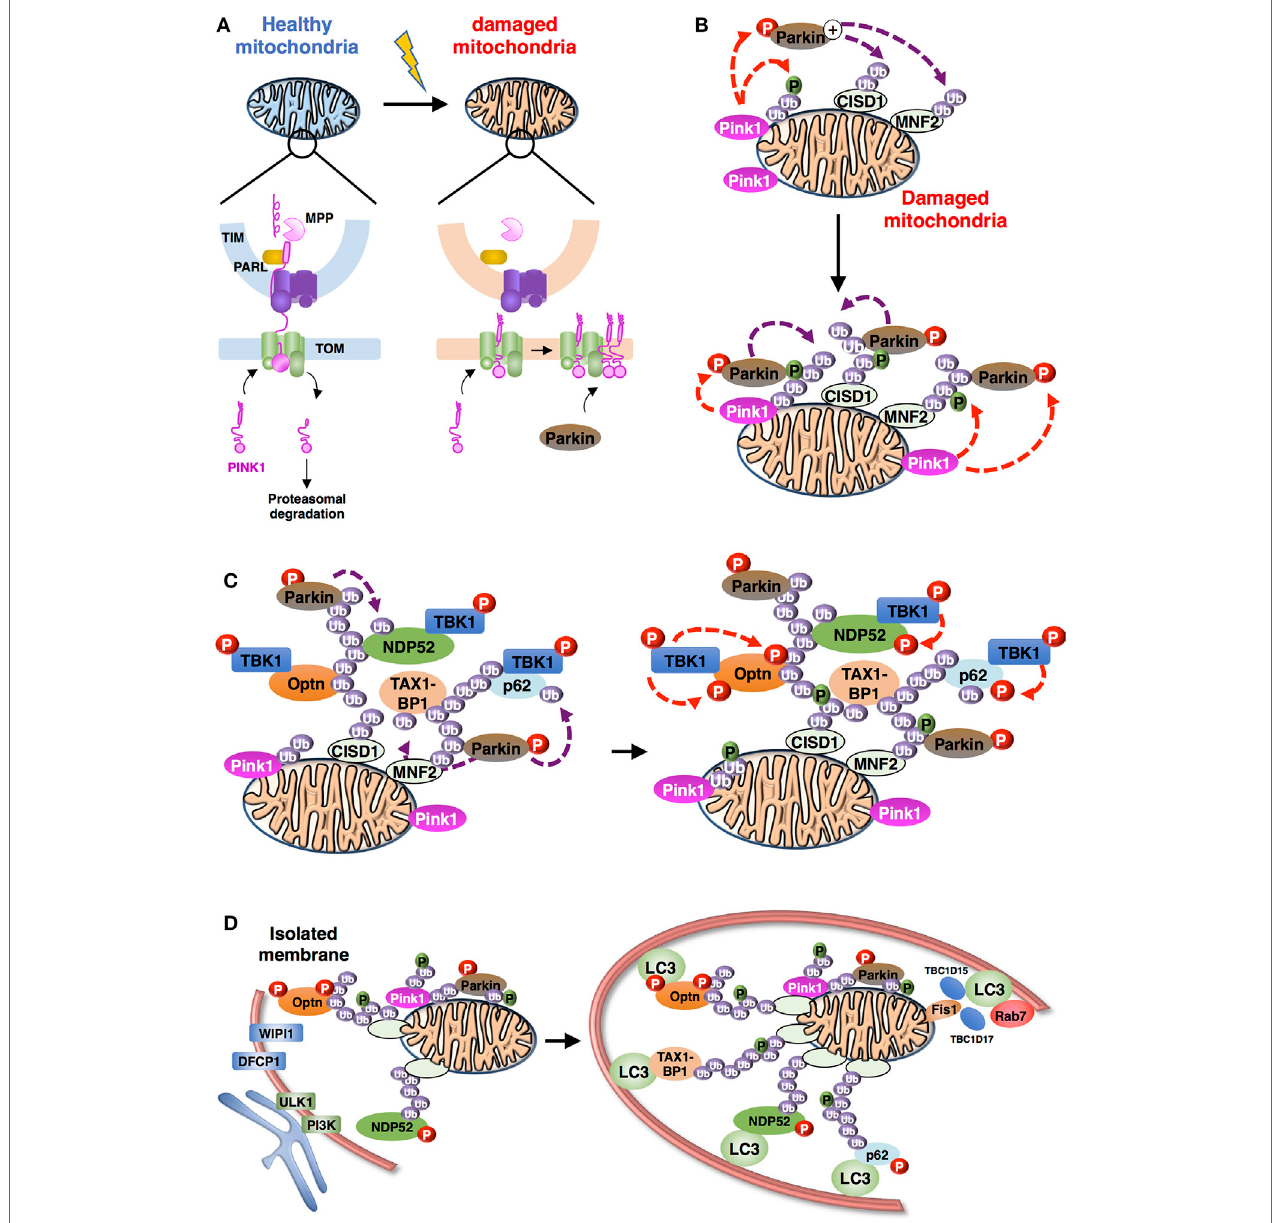
FigURe 3 | Schematic representation of the overall process of mitophagy [adapted from Ref. (36)]. (A) PINK1 import and accumulation mechanisms into mitochondria. PINK1 detects mitochondrial damage via selective proteolysis. Continuous import and the degradation cycle explain the undetectable levels of PINK1 on healthy mitochondria. Upon damage, import into the inner membrane is blocked leading to accumulation of uncleaved PINK1 on the outer mitochondrial membrane. Abbreviations: TOM, translocase of the outer mitochondrial membrane complex; TIM, translocase of the inner mitochondrial membrane complex; MPP, mitochondrial processing peptidase; PARL: presenilin-associated rhomboid-like protein. (B) Positive feedback ubiquitination cycles induced by Parkin and Ub chains on damaged mitochondria. Mitochondria-recruited PINK1 phosphorylate Ub chains conjugated to mitochondrial proteins, including CISD1 and MNF2 (shown here), as well as cytosolic Parkin, subsequently recruited to mitochondria. Activated Parkin can elongate Ub chains that can be, in turn, phosphorylated by PINK1. (C) Recruitment and activation of autophagy receptors during Parkin/PINK1-mediated mitophagy. Autophagy proteins, including adaptors [Optineurin (Optn), nuclear dot protein 52 (NDP52), p62, and Tax1 binding protein 1 (TAX1BP1) presented] and regulators (TANK-binding kinase-1, TBK1) are recruited to the mitochondria. TBK1-phosphorylation of autophagy adaptors can enhance their Ub-binding activities and promote the recruitment of the light chain 3 (LC3)-labeled isolation membrane. (D) Autophagosome biogenesis during mitophagy. Formation of autophagophore vesicle surrounding damaged mitochondria is a multi-independent process. (i) Optn and NDP52 mediate initiation and elongation of autophagosomes (at ER-mitochondria contact sites for example) via recruitment of complexes containing ULK1, PI3K, WIPI1, and DFCP1. (ii) Autophagy receptors also mediate recruitment of LC3/GABARAP family members to promote expansion of the isolation membrane. (iii) Finally, Rab-GAPs, TBC1D15, and TBC1D17, localized to mitochondria via interaction of Fis1 can regulate proper autophagosomal formation by modulating Rab7